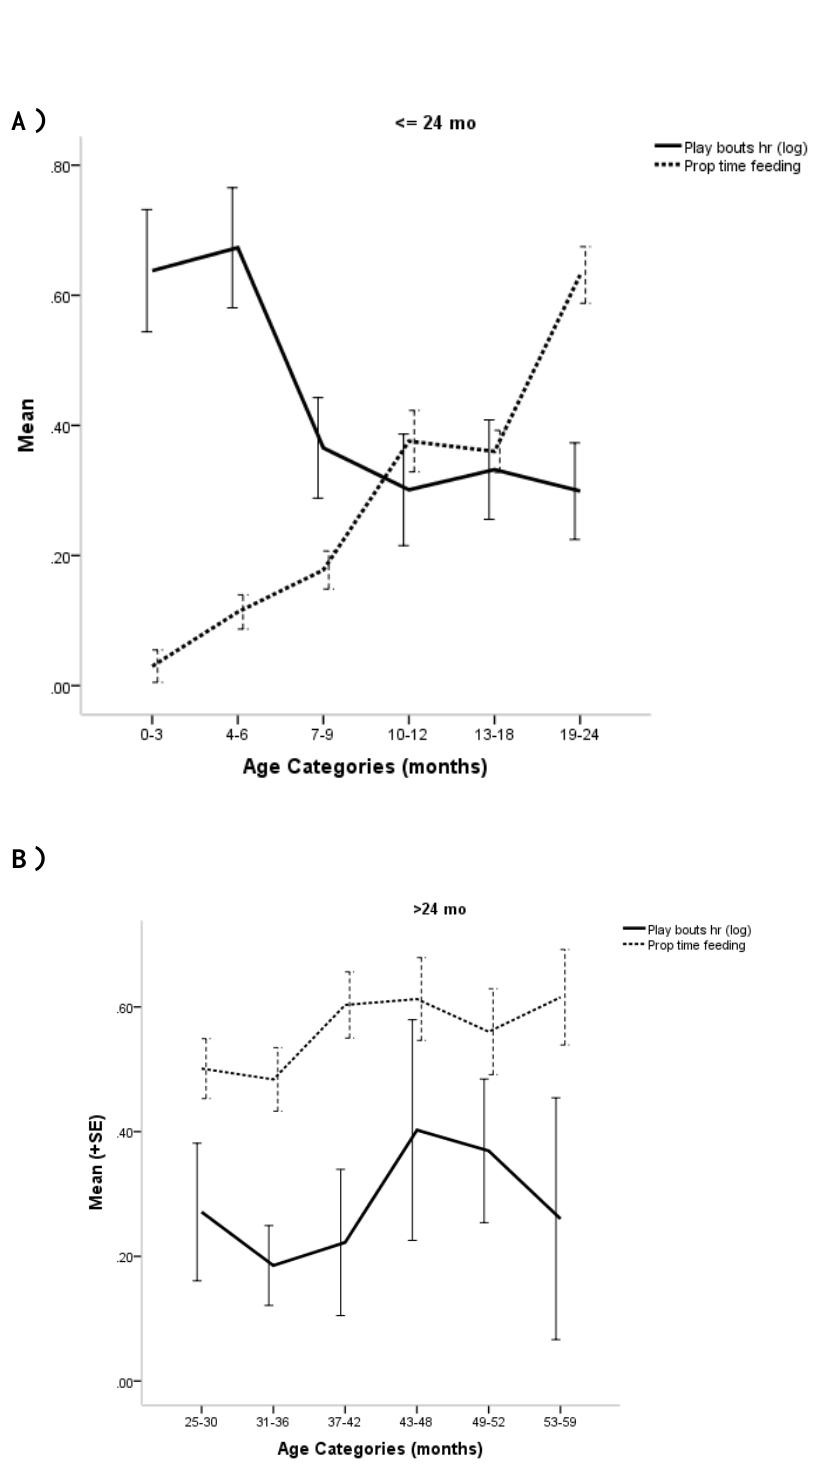
Figure 3. The relationships between the mean (± SE) proportion of time spent in independent feeding and rates of play for calves ( A ) <= 24 months and ( B ) > 24 months of